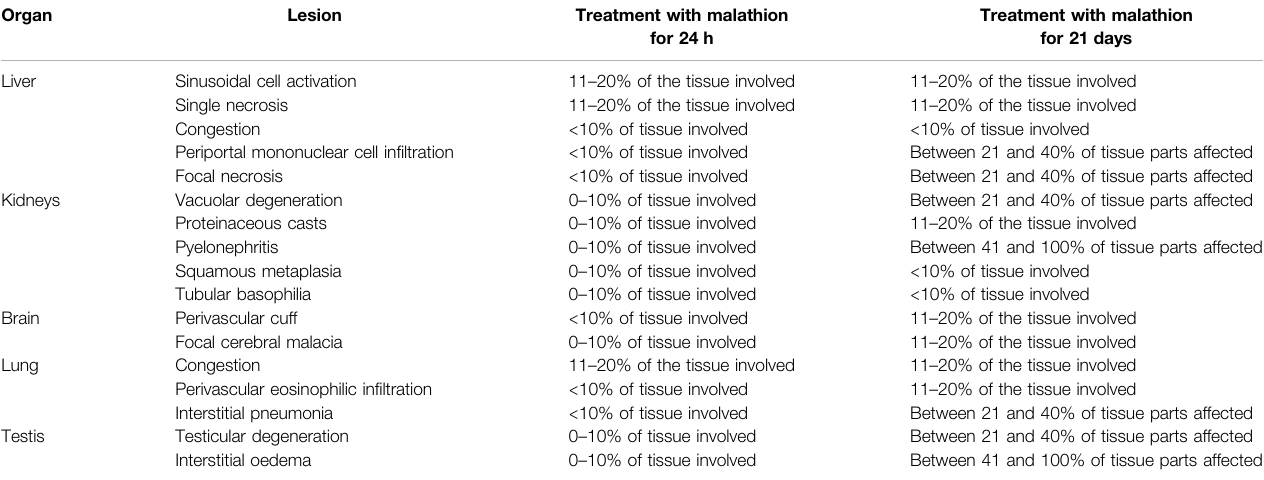
TABLE 1 | Lesions and scoring criteria for reported histopathological lesions of the liver, kidneys, brain, lung, and testis scored in the rats treated with malathion. Organ Lesion